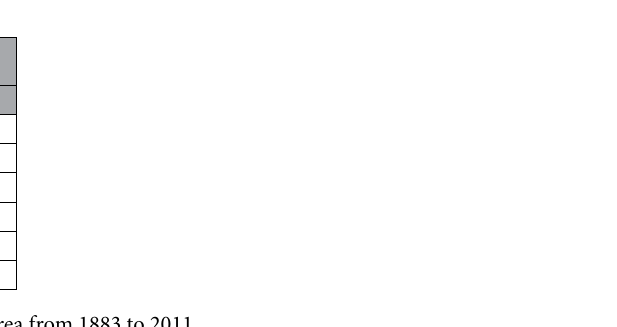
Table 2. Land gradients in the Bytom area from 1883 to